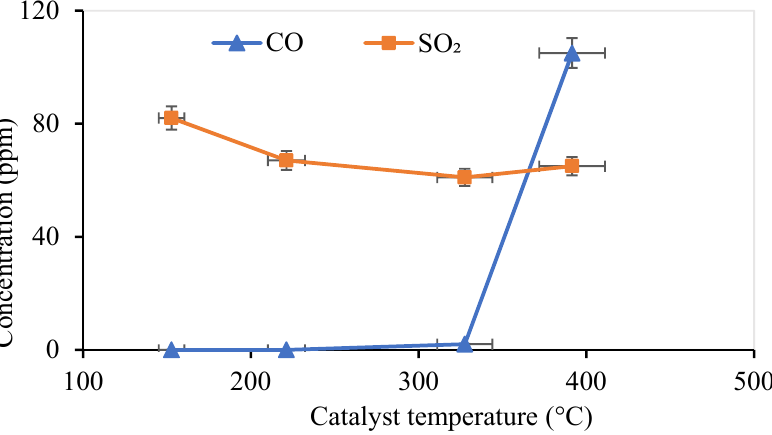
Figure 8. Catalyst temperature effect on CO and SO 2 concentration from RB combustion at 600 °C. The small error bars (%error bars) indicate high reliability and low variability.